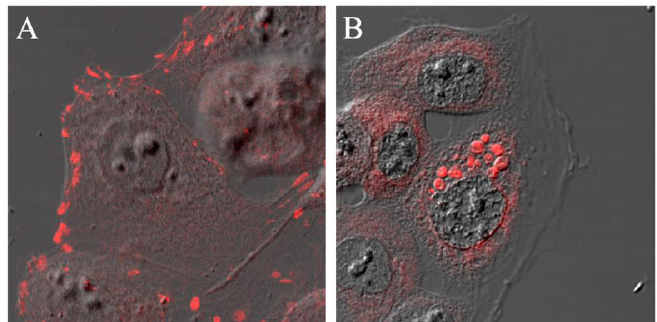
FIGURE 2. NAC treatment drives c-Src, mostly in the active Tyr419- phosphorylated form, into acidic endosomes. Confocal images of c-Src antiphosphoTyr419 (red) merged with phase contrast images, in control (A) and NAC-treated (15 min) (B) OVCAR-3 cells. Frame: 77 µm. Redrawn from Krasnowska et